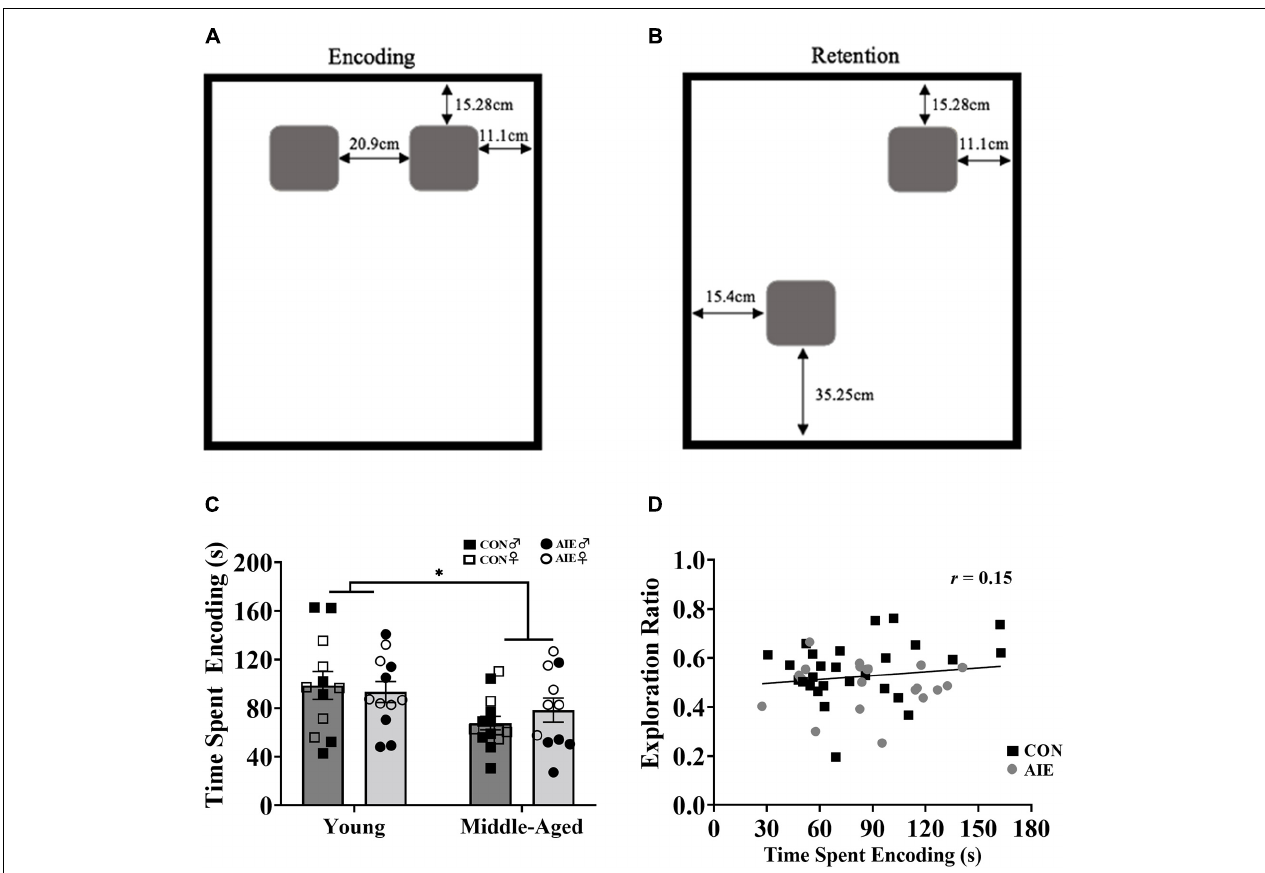
FIGURE 3 | Rats underwent two encoding sessions (6 min each) followed by one retention test (6 min). (A) Set up of identical wooden blocks during the encoding phase of NOP. (B) Set up of identical wooden blocks during the retention testing phase of NOP. One object was moved to a novel location. (C) Exploration time during the encoding phase of NOP. Middle-aged rats, regardless of ethanol exposure, spent less time exploring the objects compared to young rats ( ∗ p = 0.006). (D) Despite middle-aged rats spending less time with objects during the encoding phase and performing worse on the NOP task, encoding exposure time does not reliably predict retention test exploration ratios ( r = 0.15 , p = 0.318). For NOP results: Young control males ( n = 6), young control females ( n = 6), young AIE males ( n = 6), young AIE females ( n = 6), middle-aged control males ( n = 8), middle-aged control females ( n = 6), middle-aged AIE males ( n = 5), middle-aged AIE females ( n =